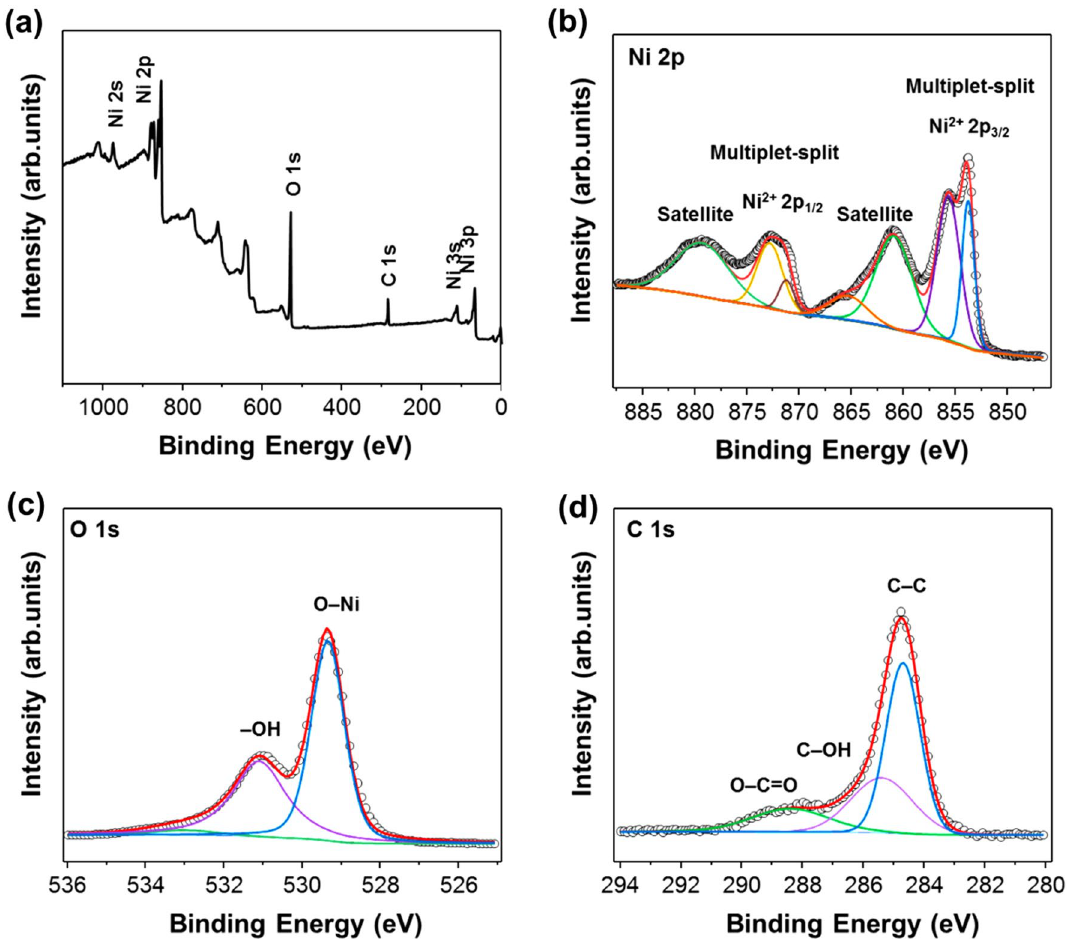
Fig. 4 a XPS survey spectrum. High-resolution XPS profiles of H–Ni/NiO/C: b Ni 2p, c O 1 s, and d C 1